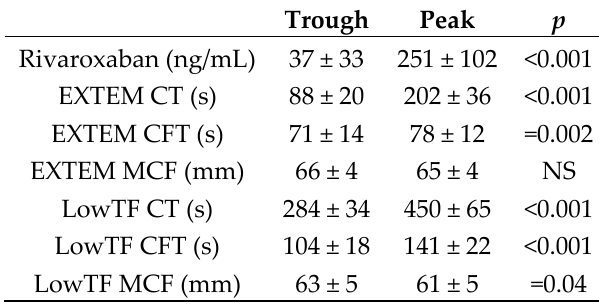
Table. Rivaroxaban concentrations and ROTEM ® parameters at trough and peak. Average ± standard deviation or median (first to third quartile) is